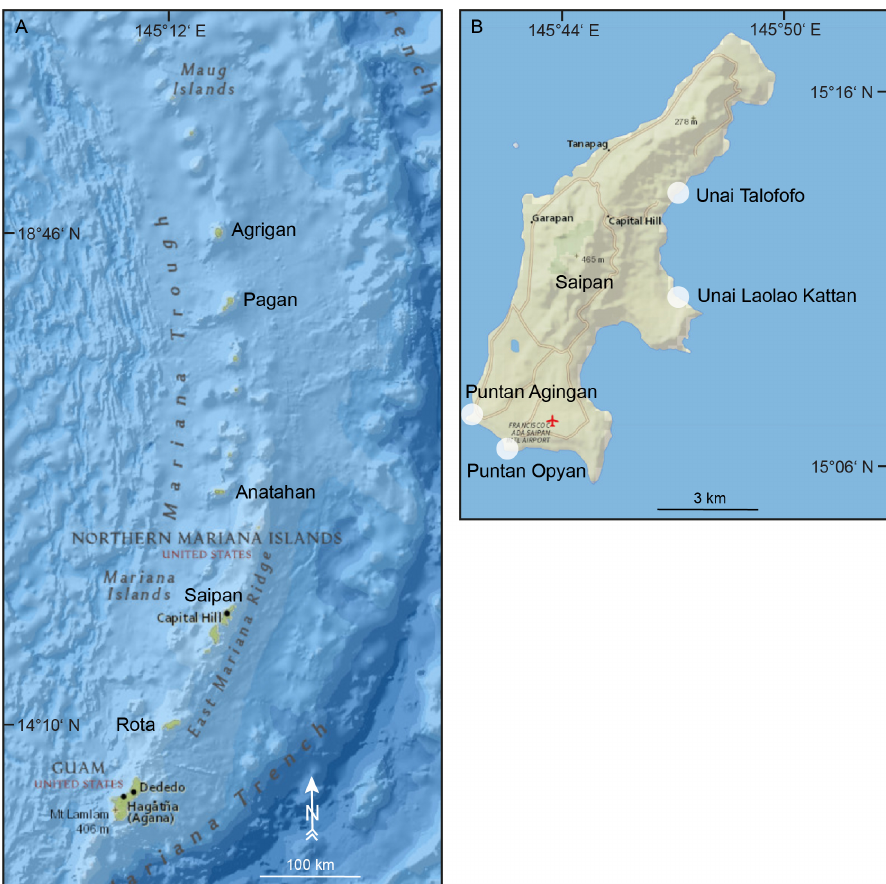
Figure 12. Map showing Guam and islands in the Northern Mariana Islands considered in this article. Study sites on Saipan are indicated by white circles. Basemap: “National Geographic Map”, with data from National Geographic, Esri, Garmin, HERE, UNEP-WCMC, USGS, NASA, ESA, METI, NRCAN, GEBCO, NOAA and INCREMENT P